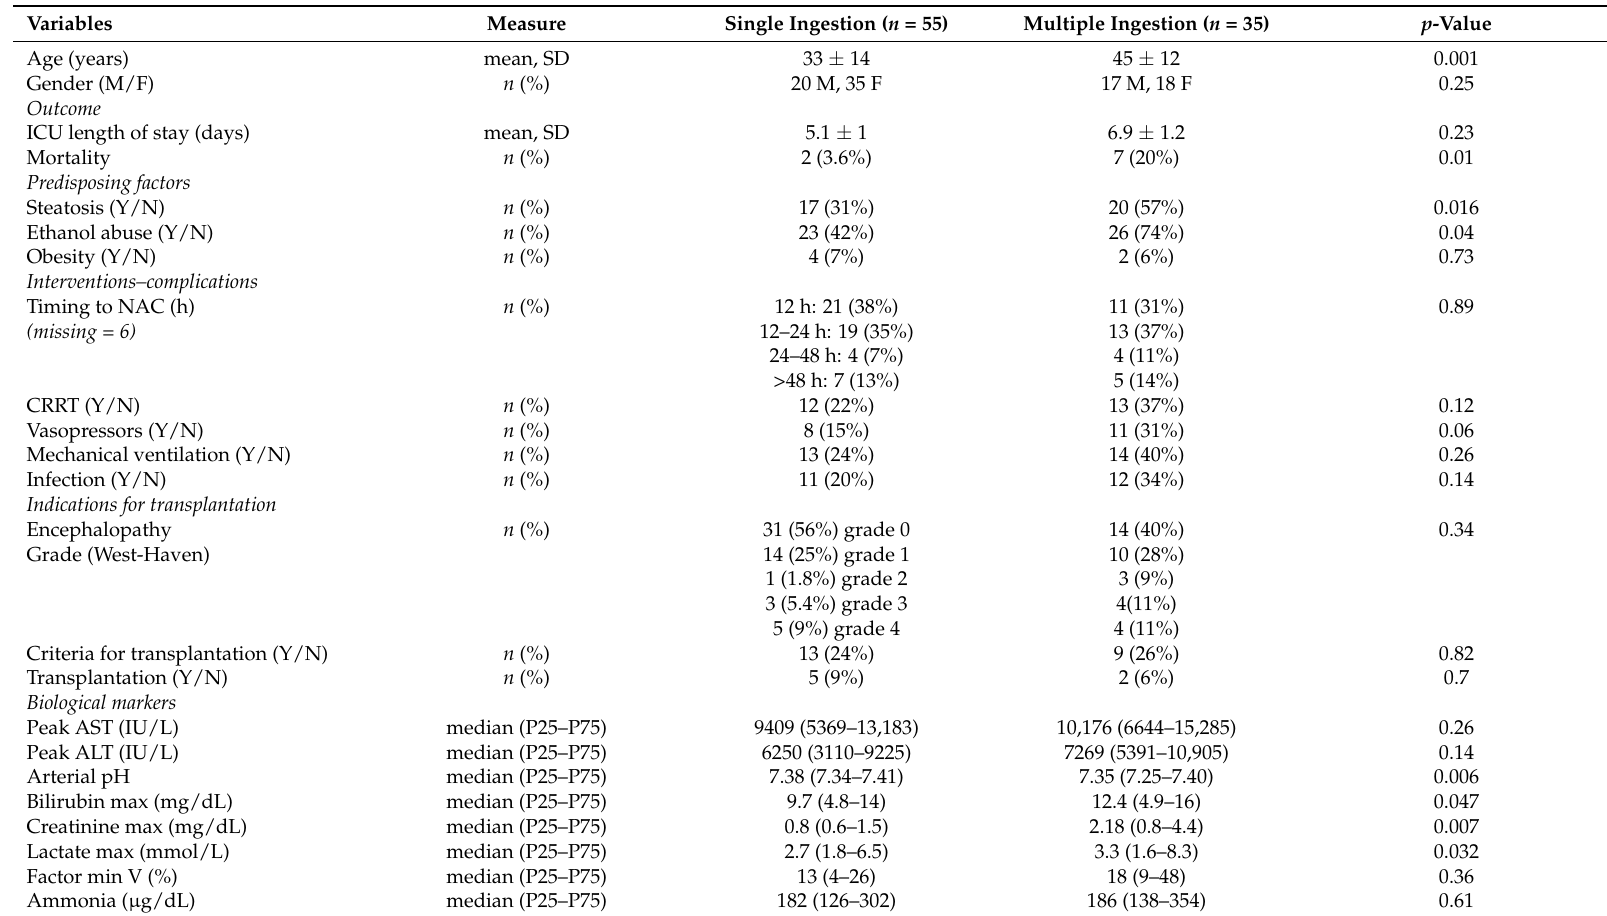
Table 1. Main results in the subgroups with single or multiple ingestion. Legend: ICU, intensive care unit; CRRT, continuous renal replacement therapy; APAP × AT, paracetamol–aminotransferase product; AUC, area under the curve; NAC, N-acetylcysteine; AST, aspartate transaminase; ALT, alanine